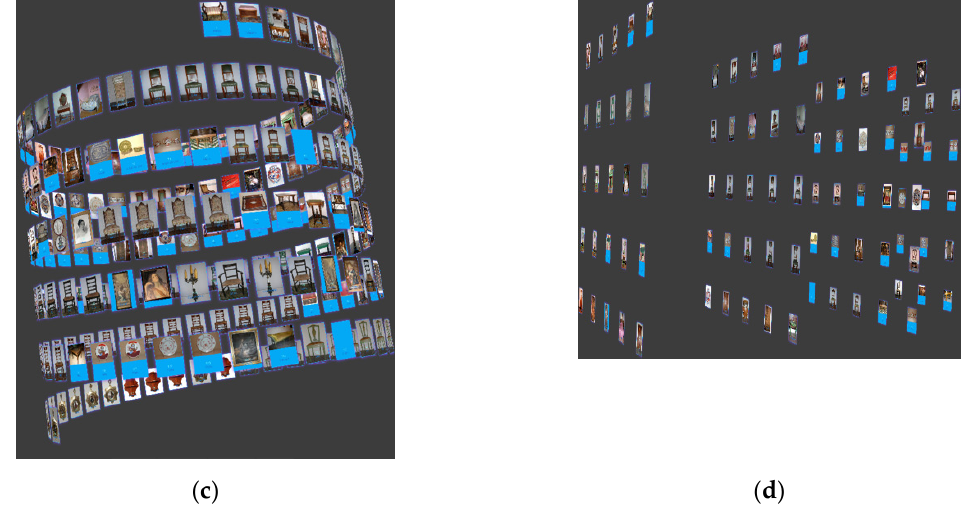
Figure 8. Different arrangements of the 3D gallery: ( a ) plain; ( b ) sphere; ( c ) helicoidal; ( d ) grid.